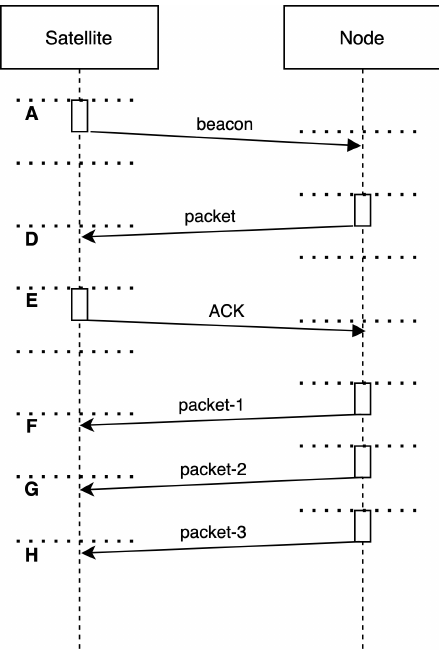
Figure 4. Sequence diagram for random access synchronised